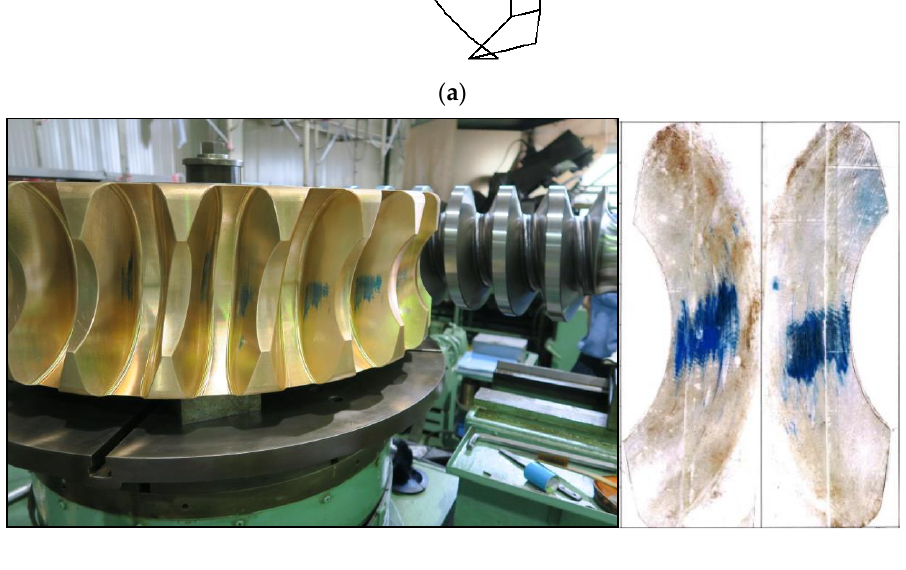
Figure 12. Compared results of analytical and experimental tooth contact patterns. ( a ) Analytical tooth contact pattern. ( b ) Experimental tooth contact pattern.